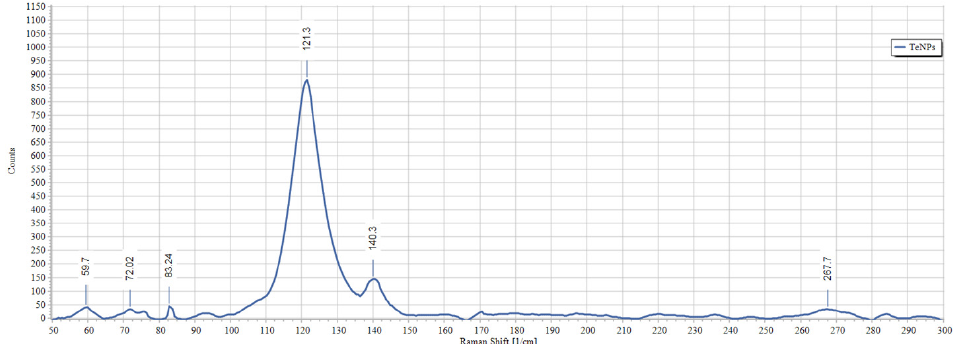
Figure 7. RAMAN spectrum of the biogenic TeNPs produced by Gayadomonas sp. TNPM15.